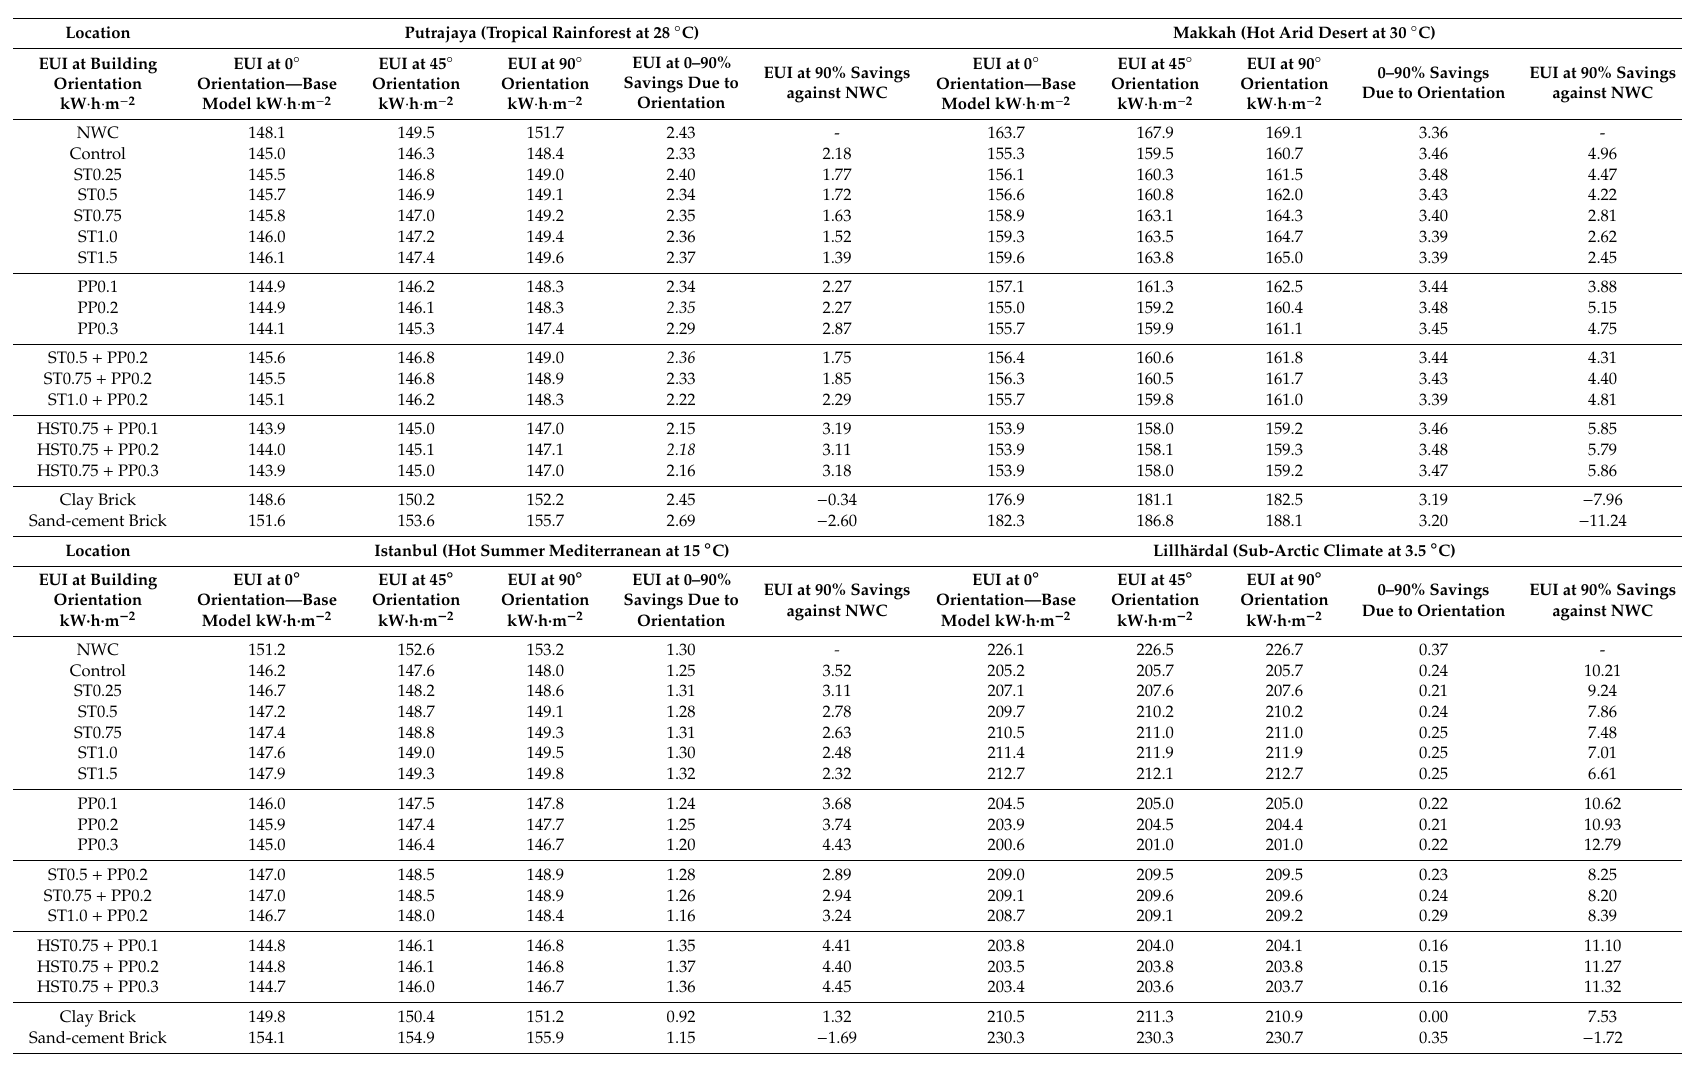
Table 5. Energy use intensity (EUI) performance and savings compared to NWC at di ff erent orientations, continued.